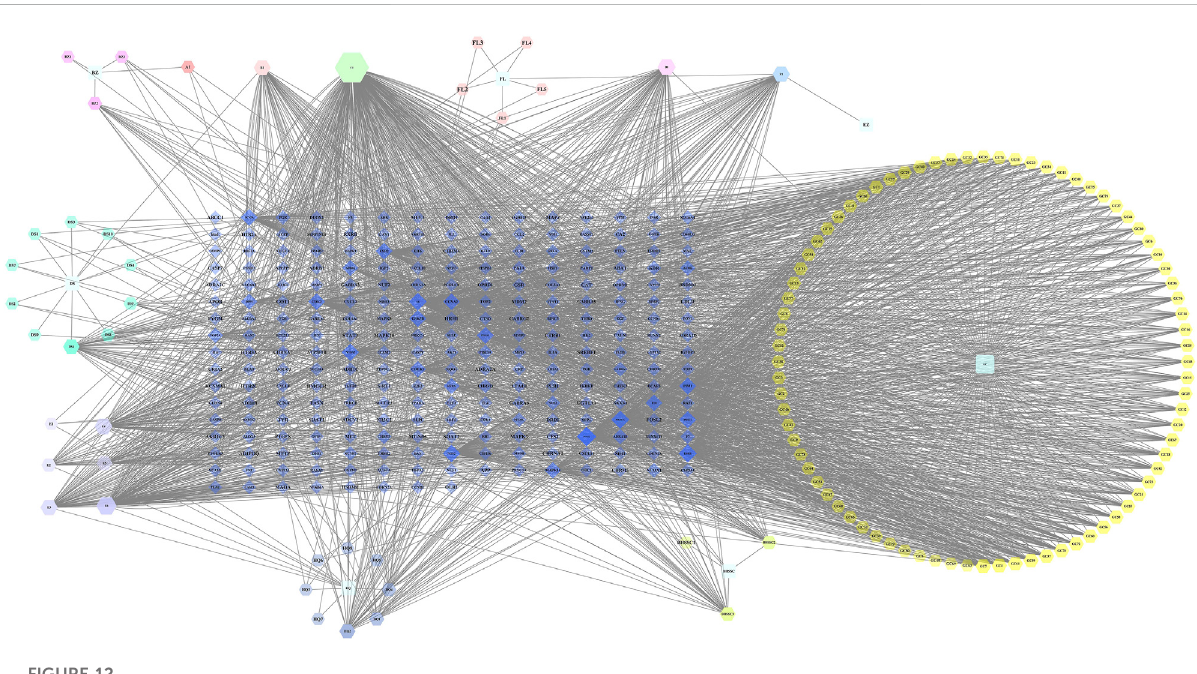
FIGURE 12 Network of Herb-Component-Target.